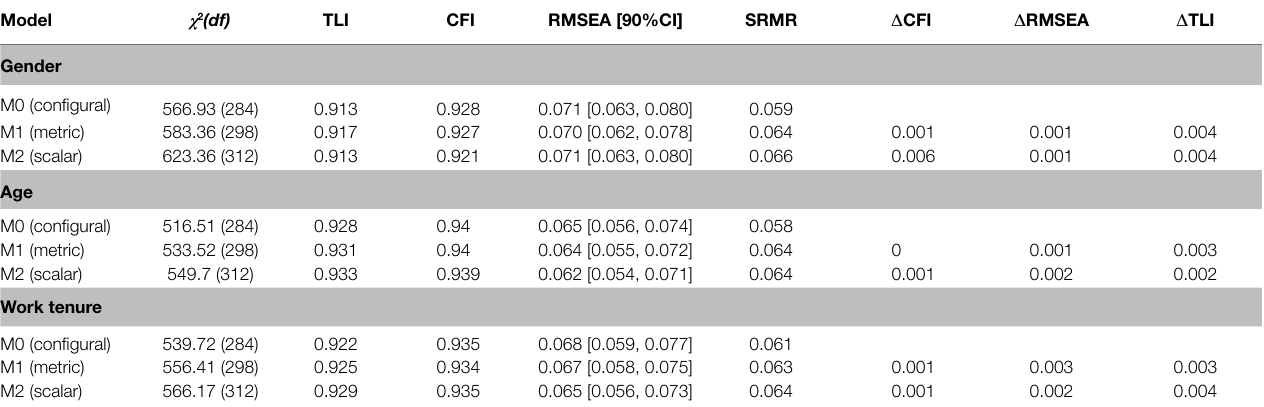
TABLE 3 | Test of Measurement Invariance Across Gender, Age, Work tenure in Study 2. Model χ 2 (df)